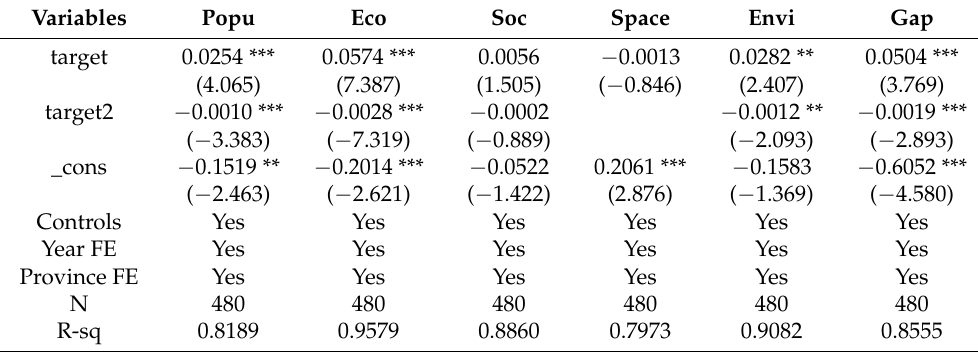
Table 5. Impact of economic growth targets on the six dimensions of new urbanization.